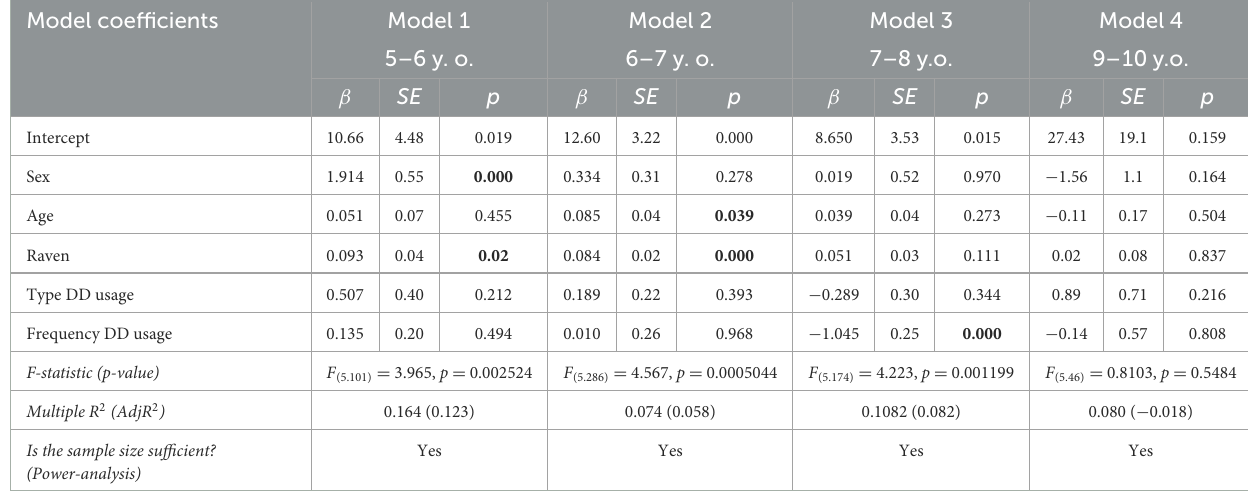
TABLE 6 Multiple linear regression analysis for the study variables predicting cognitive flexibility from the senior kindergarten group to third school